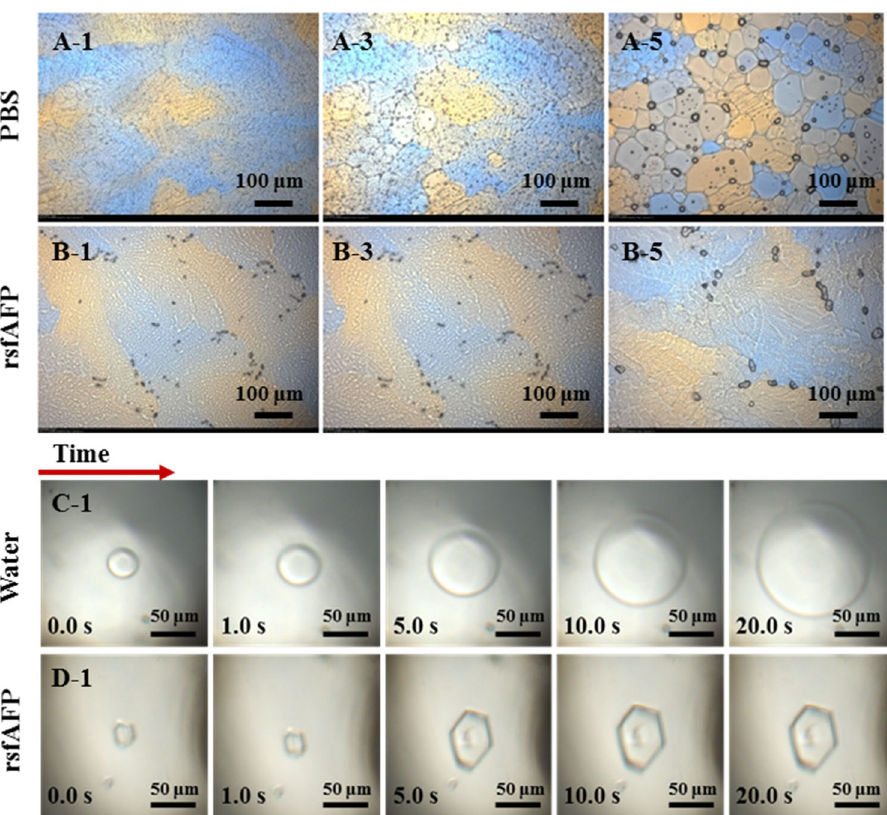
Fig. 3 Optical images show the completely different growth behaviors and shapes of ice crystals with or without rsfAFP. A , B The effects of rsfAFP on ice recrystallization in PBS (50 mM NaH 2 PO 4 , 300 mM NaCl, pH 8.0) after different thermal cycles between − 14 and − 12 °C. A-1 , A-3 , and A-5 show the ice crystal growth without rsfAFP before, after 3 cycles and 5 cycles, respectively. B-1 , B-3 , and B-5 show the ice crystal growth with rsfAFP (0.1 mg/mL) before, after 3 cycles and 5 cycles, respectively. The morphology and growth rate of a single ice crystal without ( C ) or with ( D ) addition of 0.1 mg/mL rsfAFP in ultrapure